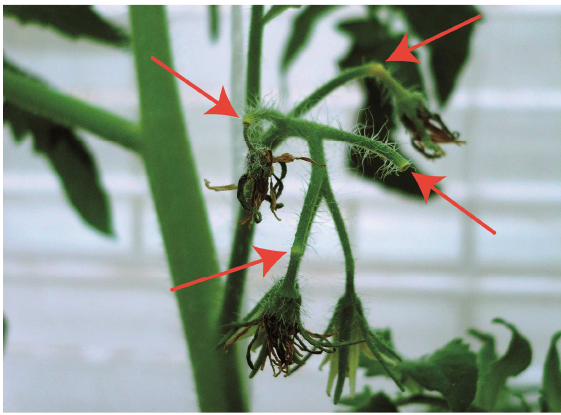
F IGURE 5. Tomato flowers damaged from intense visitation by Bombus impatiens and showing signs of abortion (red